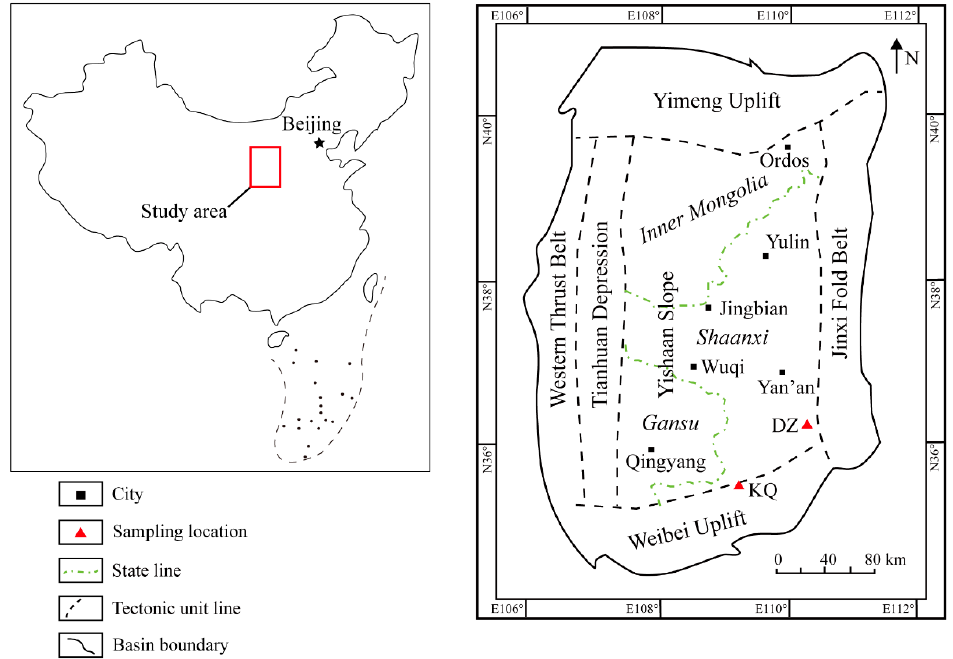
Figure 1. Map showing the tectonic units of the Ordos Basin and sampling locations. KQ = Kuquan section; DZ = Danzhou section.